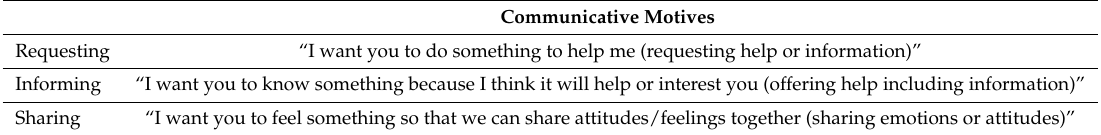
Figure 6. Modularization of robot partner system. Table 2. Three general types of evolved communicative motives